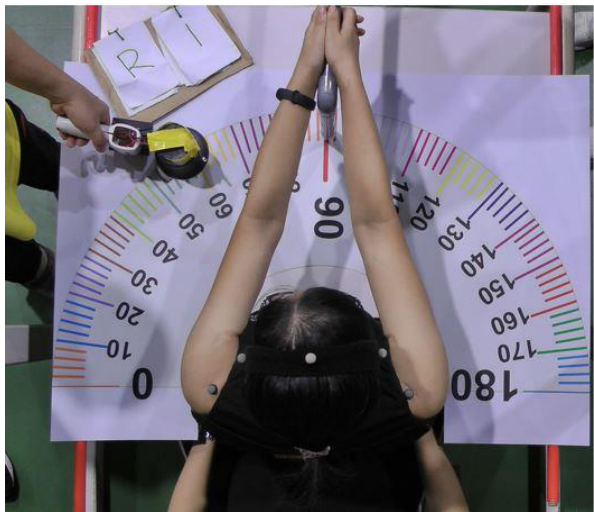
Figure 1. Initial position of each